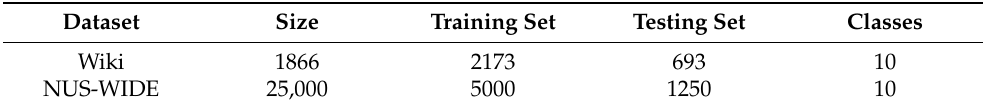
Table 2. The summary of Wiki and NUS-WIDE